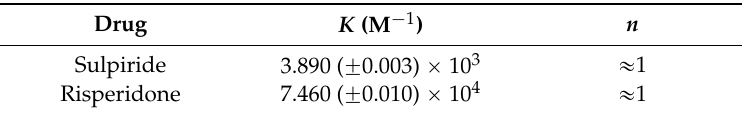
Table 2. Binding constant K and number of binding sites n for interactions risperidone–HSA and sulpiride–HSA.